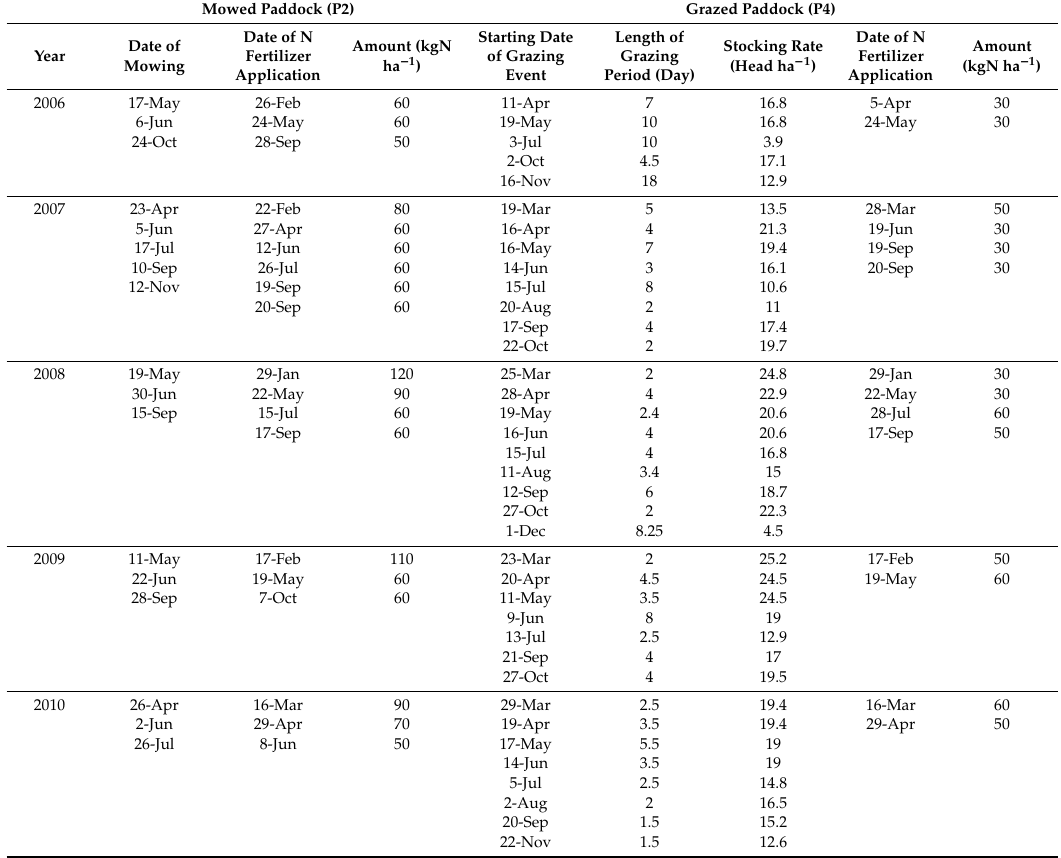
Table A1. Management records for grasslands under mowing and grazing for the period 2006–2010 at the SOERE-ACBB, Lusignan,